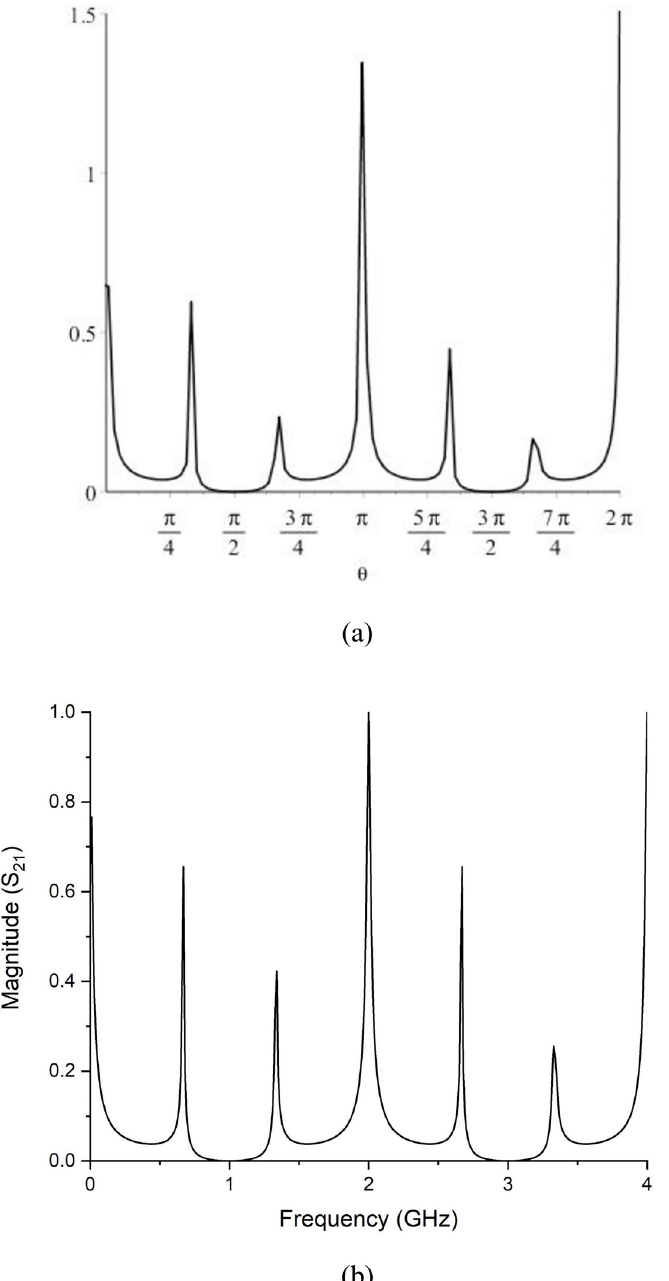
Fig 3. Comparison of S 21 Magnitude (a) Mathematical (b)